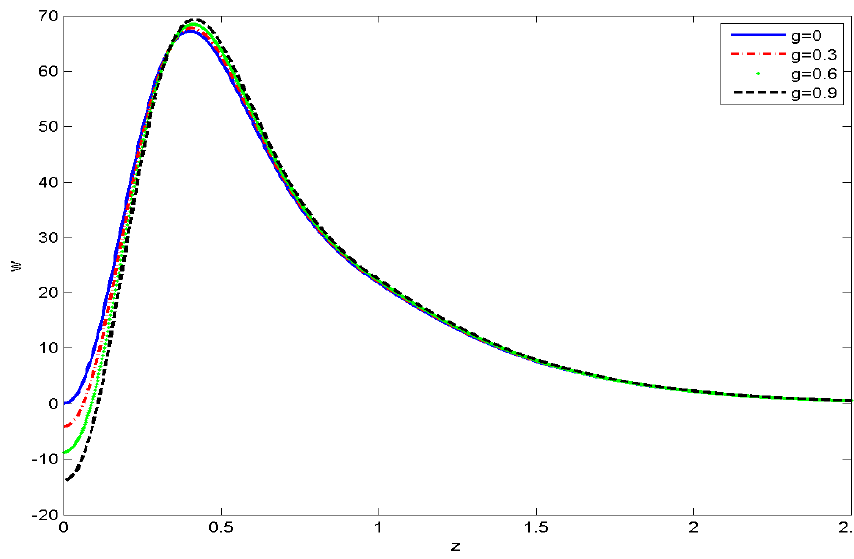
Figure 27. Vertical displacement w concerning z with gravity g.